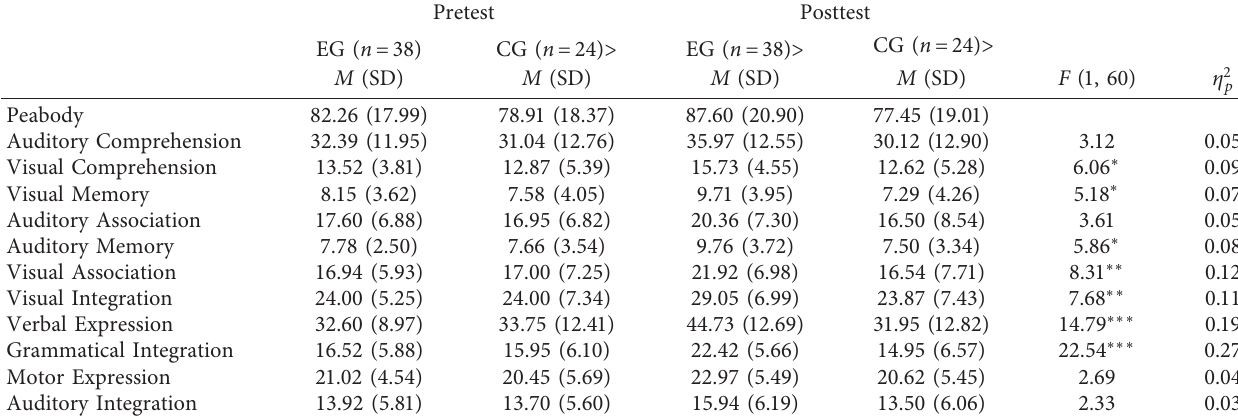
Table 1: Descriptive statistics and differences between the two groups (EG and CG) in the